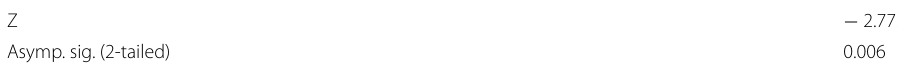
Table 6 Wilcoxon signed-rank test statistic, virtual study group-independent study Z